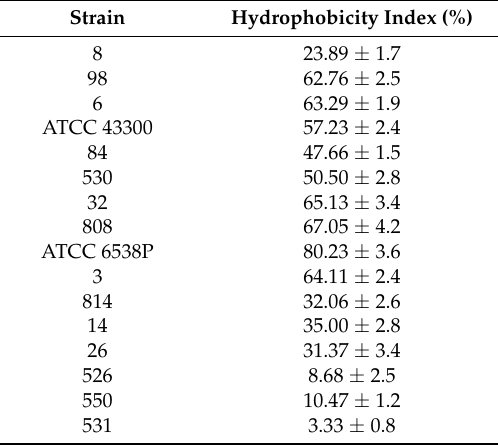
Table 5. Cell-surface hydrophobicity (expressed as % hydrophobicity index) of ATCC and clinical strains of S. aureus . Values represent the mean of three